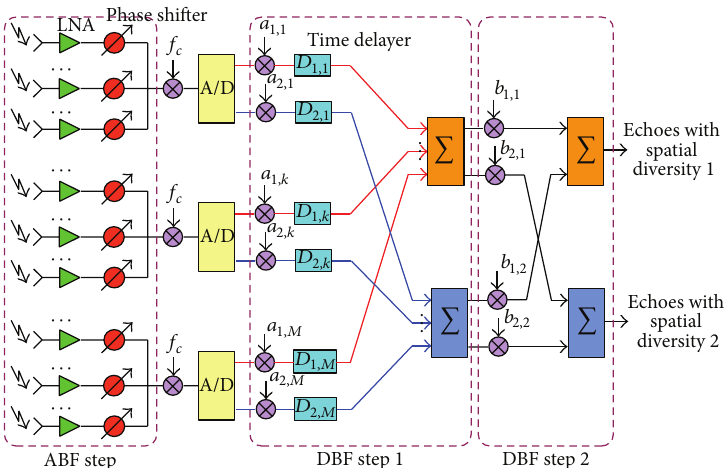
Figure 6: The block diagram of the real time DBF processor with null steering in elevation onboard.